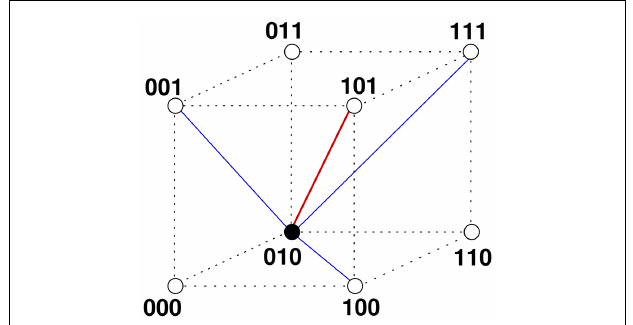
FIGURE 1 | Potential and expressed idiotypic repertoire .The figure shows all nodes whose idiotypes are encoded by bitstrings of length d = 3. The nodes can be thought as the corners of a 3-dimensional cube. Also shown are the links of node 010 (filled circle) to the node with perfect complementary idiotype 101 (red line), and to the nodes with idiotypes 100, 001, and 111, which are complementary allowing for one mismatch (blue lines).The dotted lines are only to visualize the edges of the cube.The base graph G ( m ) for d = 3 and m = 1 consists of these 2 d = 8 nodes and all links d connecting complementary nodes allowing for up to one mismatch. It represents the potential idiotypic repertoire and the possible idiotypic interactions.The influx of B cells from the bone marrow is modeled occupying empty nodes with probability p . Assume that node 010 is occupied. If the neighboring nodes representing clones of complementary idiotypes are empty, it receives no stimulation and will die. It will also die if there are too many, say all 4, nodes of complementary idiotype occupied. So the node 010 survives the update only if the number of occupied neighbor nodes is within a window [ t L , t U ] = [1,3].These steps, random influx and parallel application of the window rule for all nodes, are repeated and lead for larger dimensions d and appropriate parameters to a steady state with a complex architecture of the expressed idiotypic network, see text.